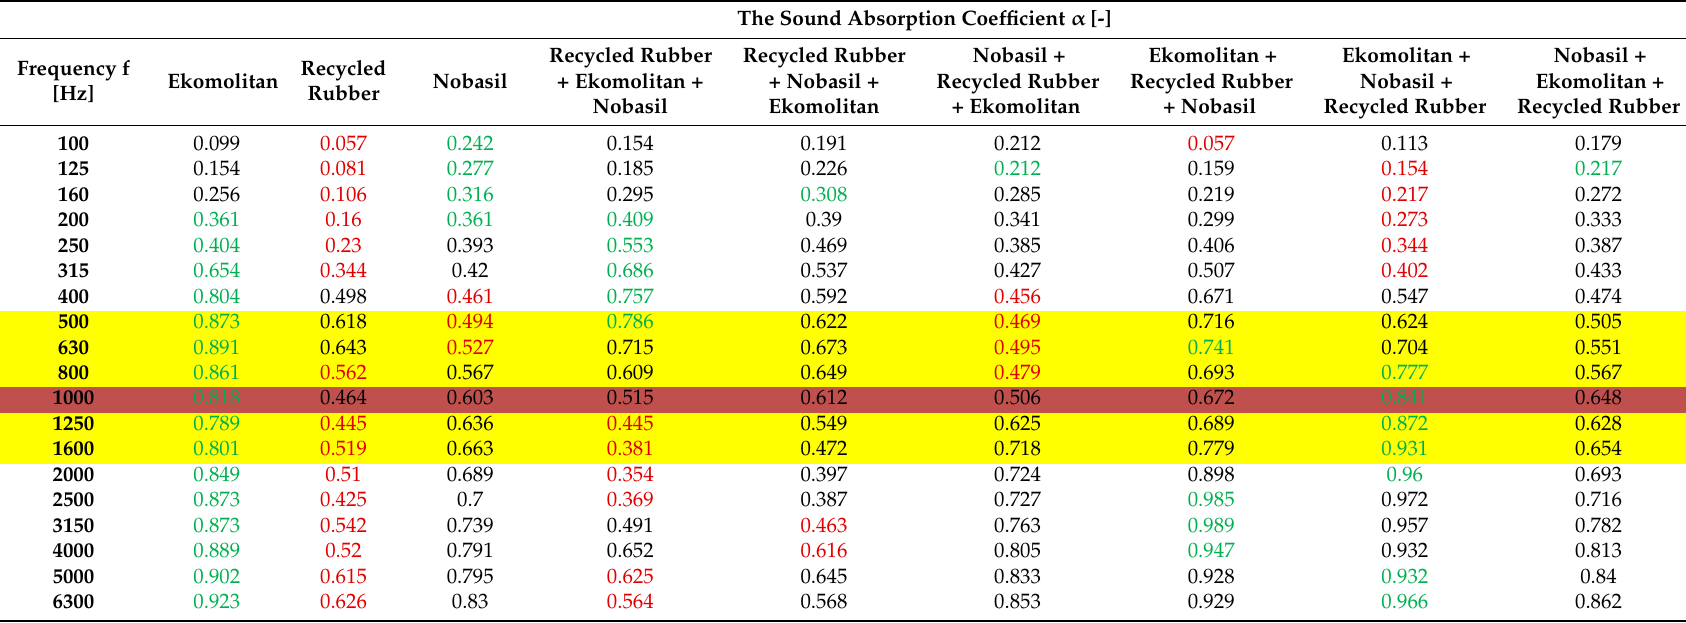
Table 1. Sound absorption coefficient values for materials with thickness of 60